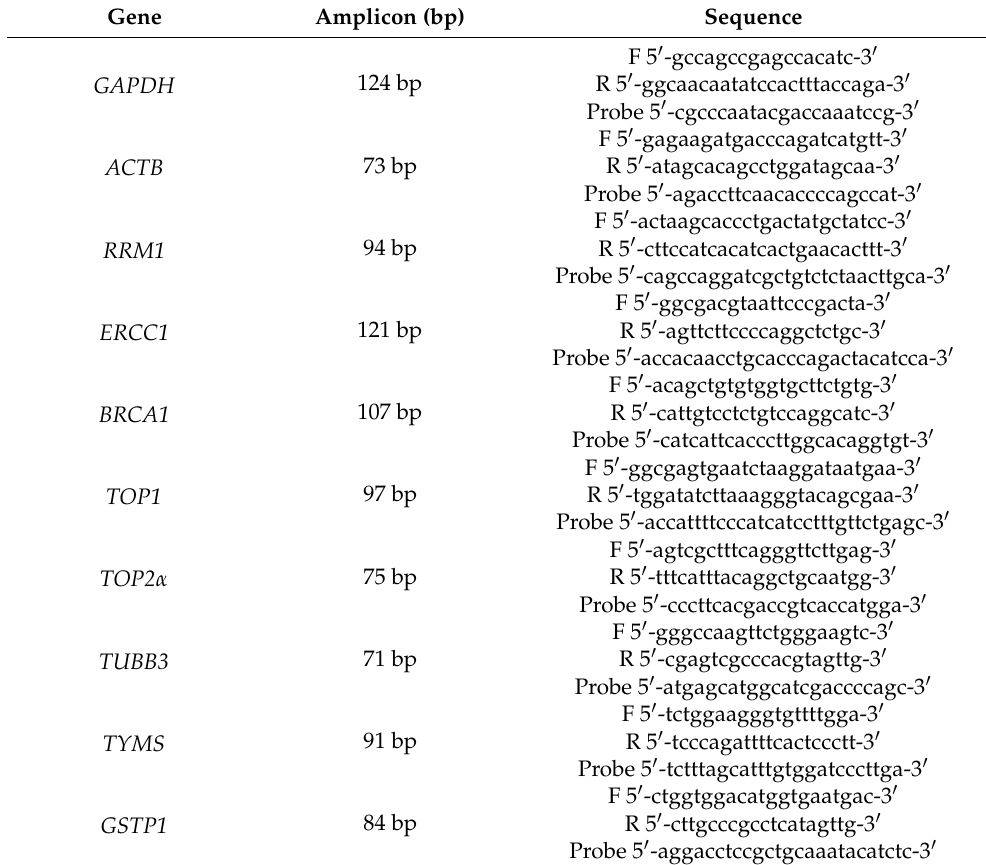
Table 3. The sequences of primers and probes of